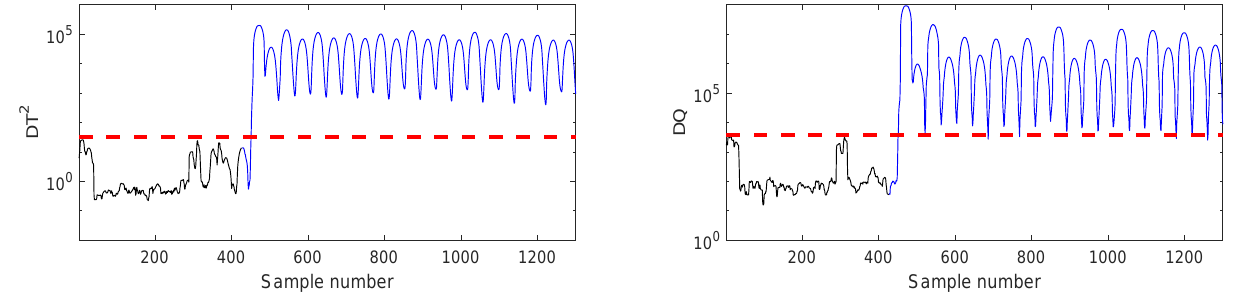
Figure 6. SLCVAkNN monitoring results on the DATA-2 case.